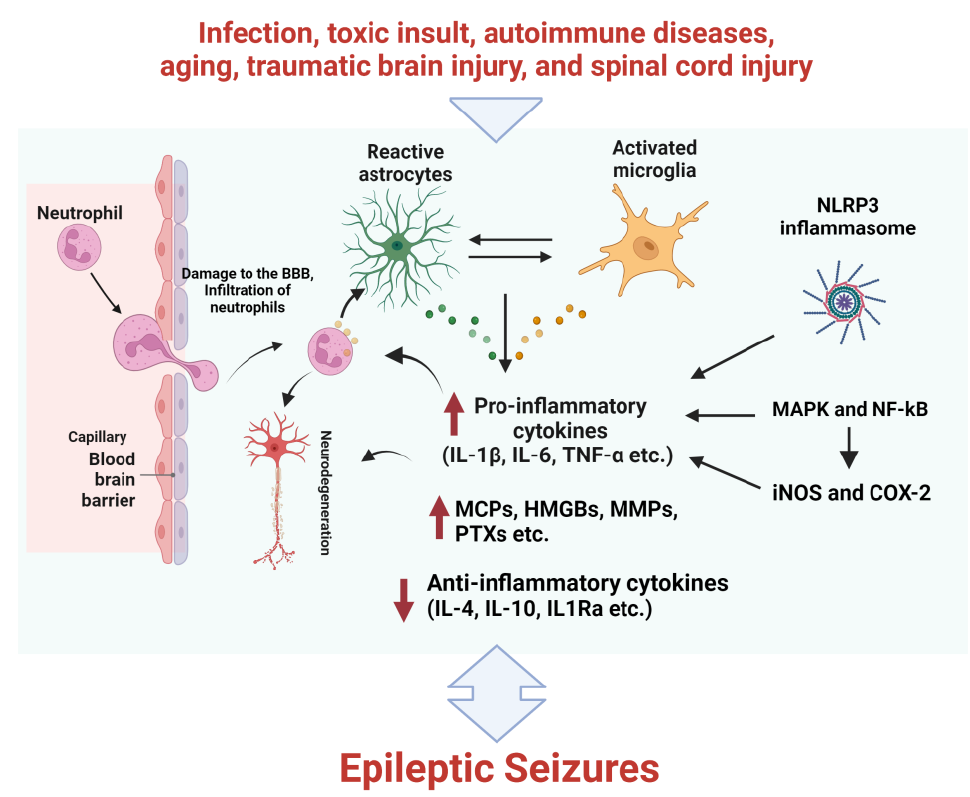
Figure 1. The neuroinflammatory process involved in epilepsy. Pathological insults caused by brain injuries, infections, genetic mutations, etc., stimulates neural cells. These cells produce and release inflammatory mediators in the brain, triggering a cascade of events that resulting in generation of epileptic